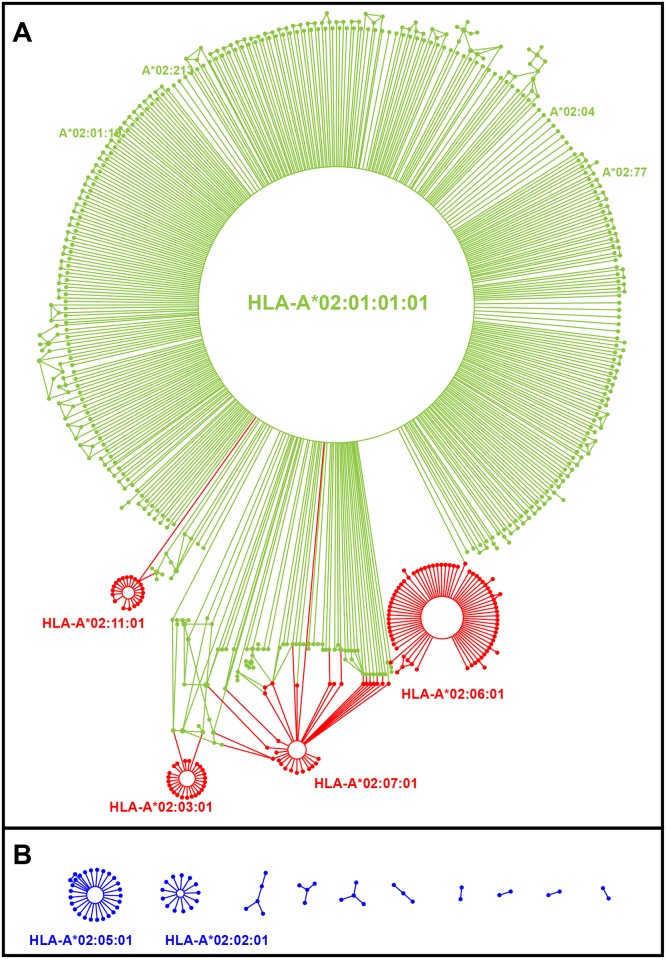
Most alleles within a SEG are related by single point substitutions.Shows all of the members of the final HLA-A*02:01:01:01 SEG. A The parental HLA-A*02:01:01:01 allele has 423 “child” alleles that vary from A*02:01:01:01 by a point substitution (green). Additional alleles can be connected by two or more point substitutions (red). In the algorithm the intermediate SEGs, for example HLA-A*02:07:01, are constructed and subsequently added to other larger SEGs. B Ten other HLA-A*02 SEGs were identified that could not directly be linked to the HLA-A*02:01:01:01 SEG because they differed from it by more than one point substitution and no intermediate alleles were identified. All of the SEGS with more than a single child are derived by intragenic recombination. Six of the seven are based on an intragenic recombinant involving the HLA-A*02:01:01:01 SEG. The seventh is the core allele HLA-A*02:05:01.